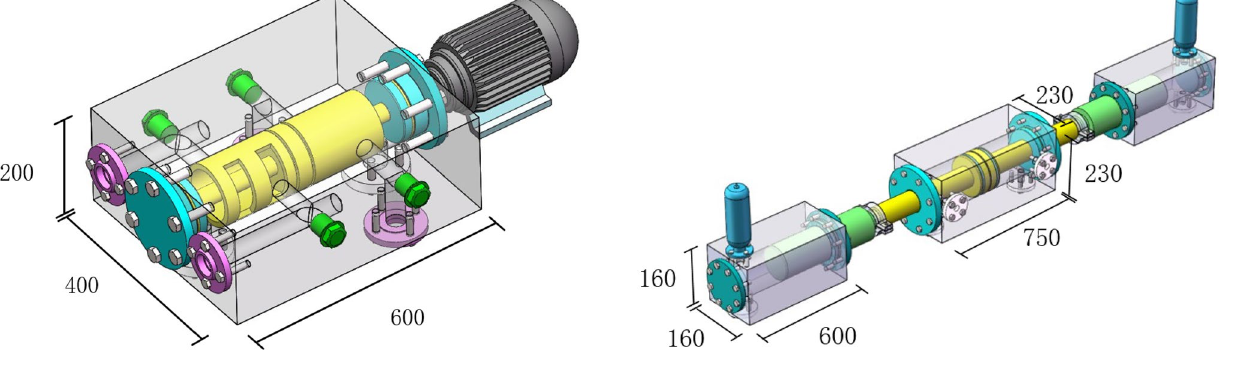
Fig. 6 Size and internal structure of the double-acting plunger